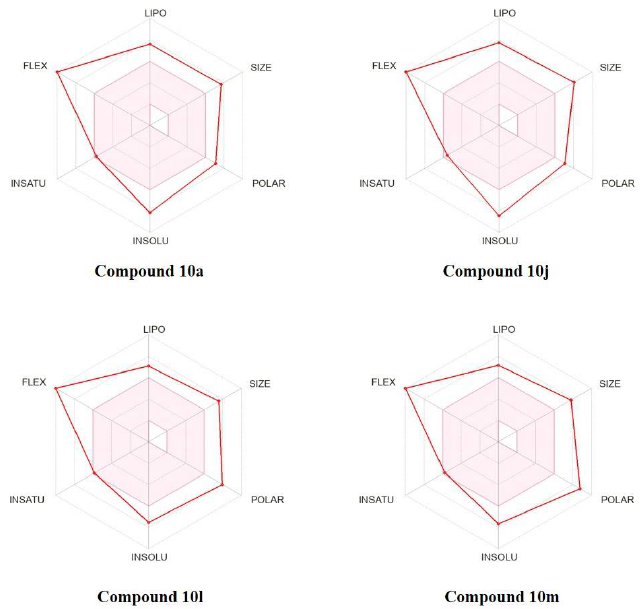
Figure 5. Bioavailability radar of four active compounds. The pink area represents the optimal range for each property. Abbreviations: LIPO (Lipophilicity), SIZE (Molecular Weight), POLAR (Polarity), INSOLU (Insolubility), INSATU (Instauration), and FLIX (Rotatable bond flexibility).